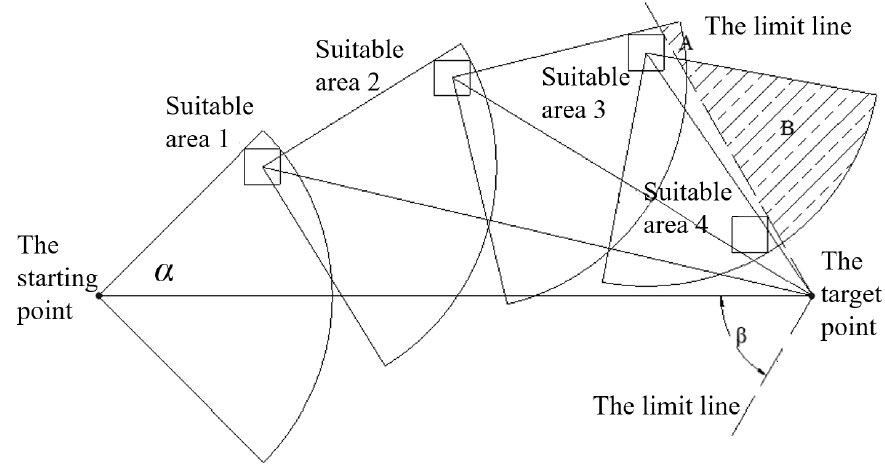
Figure 10. The generated path after adding limit line.